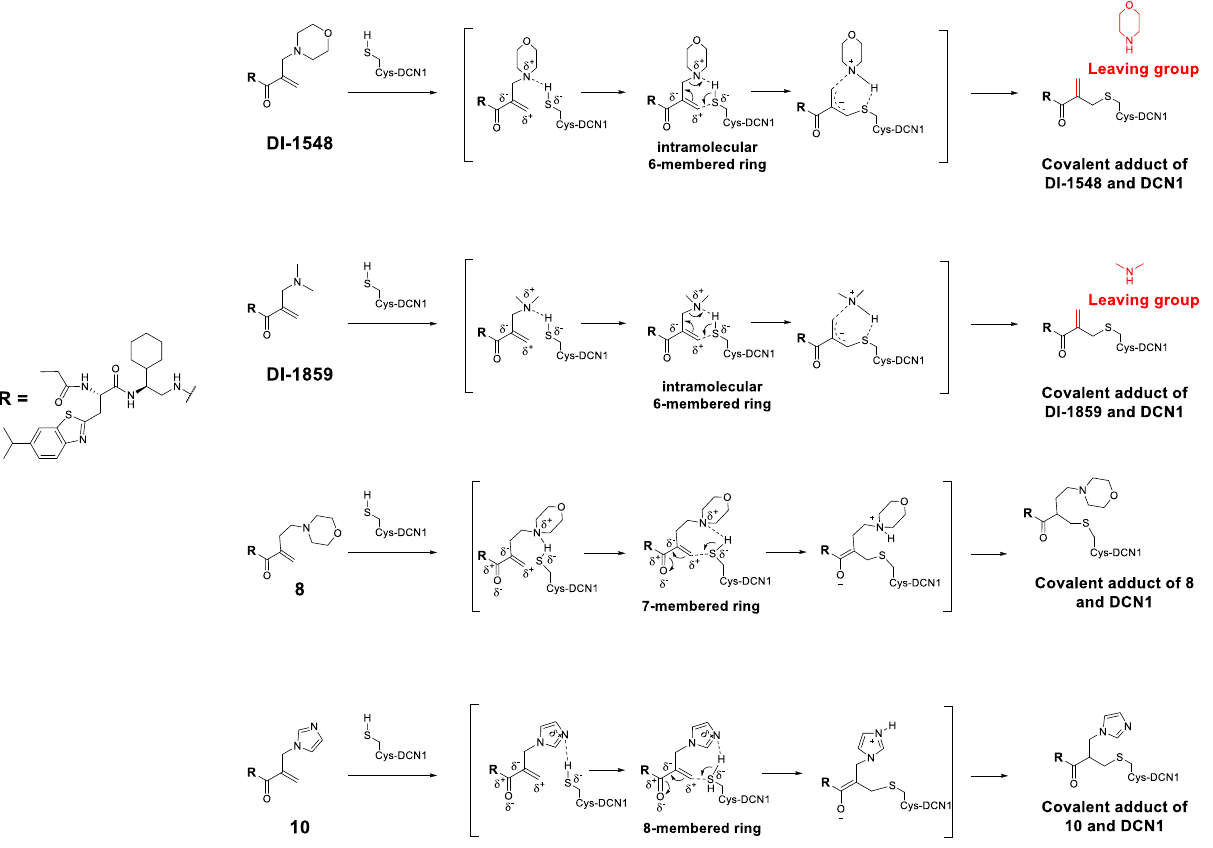
Fig. 4 A proposed mechanism of covalent complex formation between covalent DCN1 inhibitors and DCN1 protein. The proposed mechanism of the formal S N 2 ′ substitution reaction between DI-1548 or DI-1859 and DCN1 protein, and the Michael addition reaction of DCN1 protein with 8 or 10